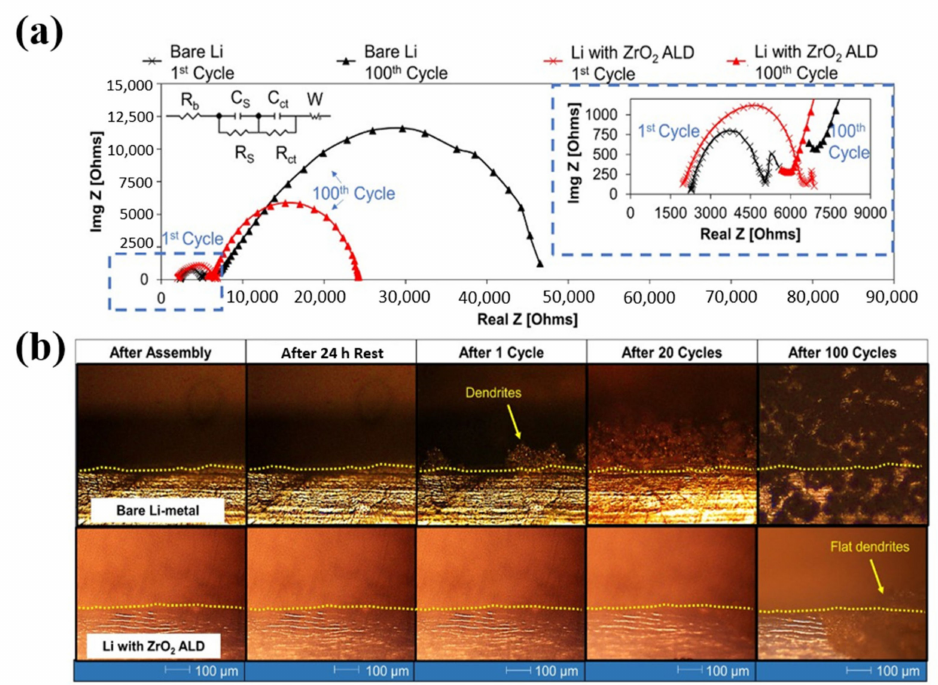
Figure 2. ( a ) EIS spectra of bare Li and ZrO 2 -coated Li at the 1st and 100th charge/discharge cycle with an inset magnification in high frequency, and ( b ) In situ optical observations of the Li/electrolyte interface during cycling for bare Li and ZrO 2 -coated Li [88]. Reproduced with permission [88]. Copyright 2018, American Chemical